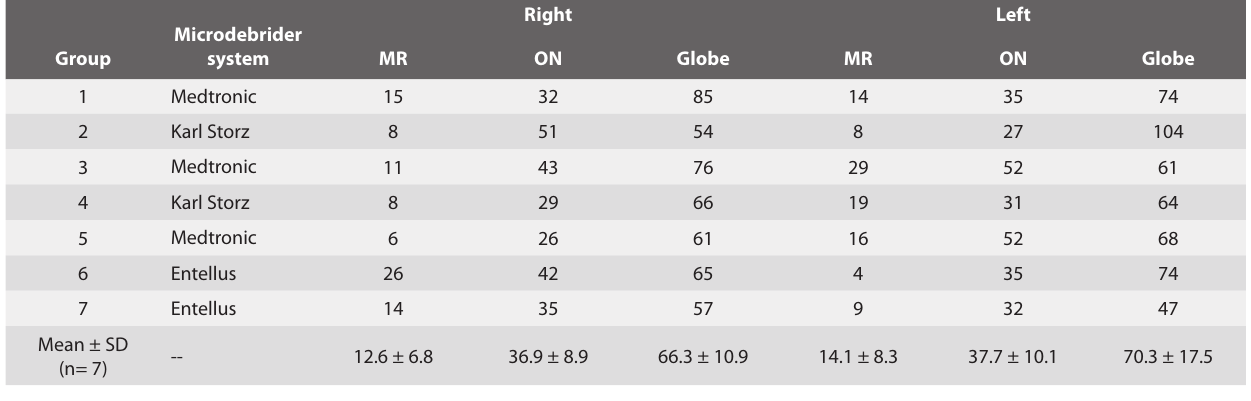
1. Timeline of microdebrider-mediated orbital structure injury in a cadaveric model a